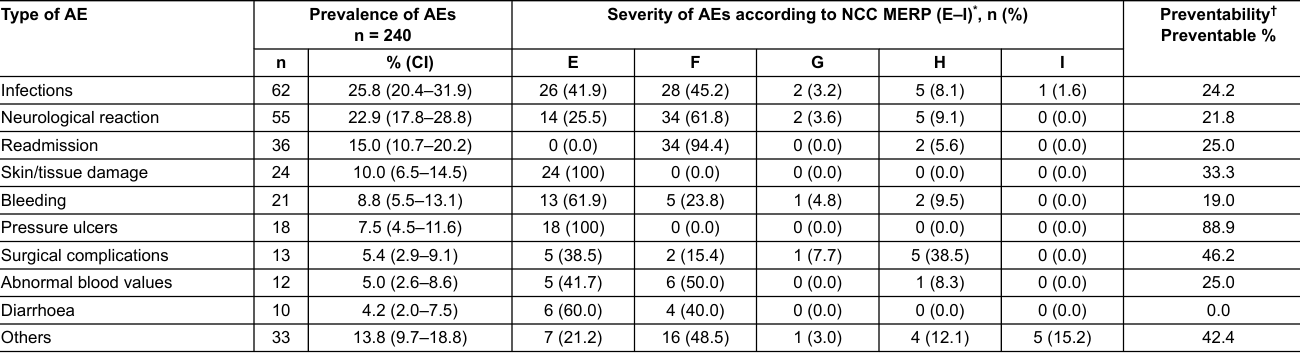
Table 3: Type, prevalence, severity and preventability of the most prevalent adverse events during hospitalisation for categories E to I only. Type of